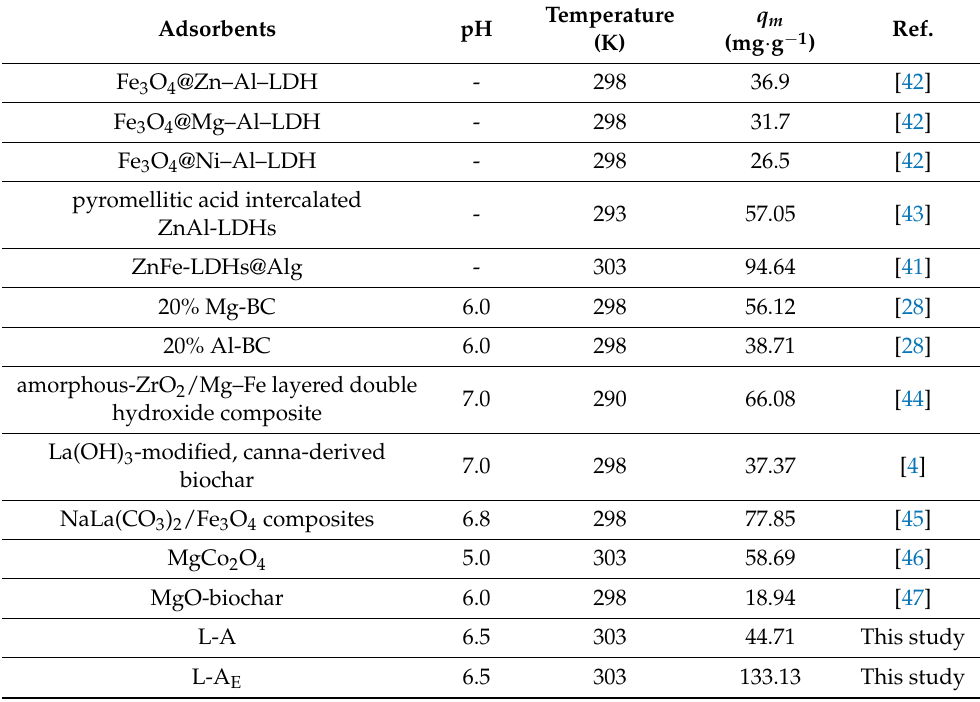
Table 2. Phosphate adsorption capacities of different